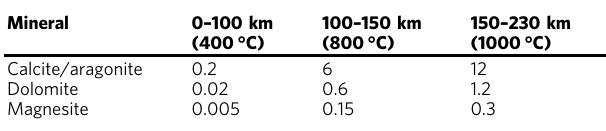
Table 2 Assumed average carbonate solubilities in 1 m NaCl aqueous solution as a function of